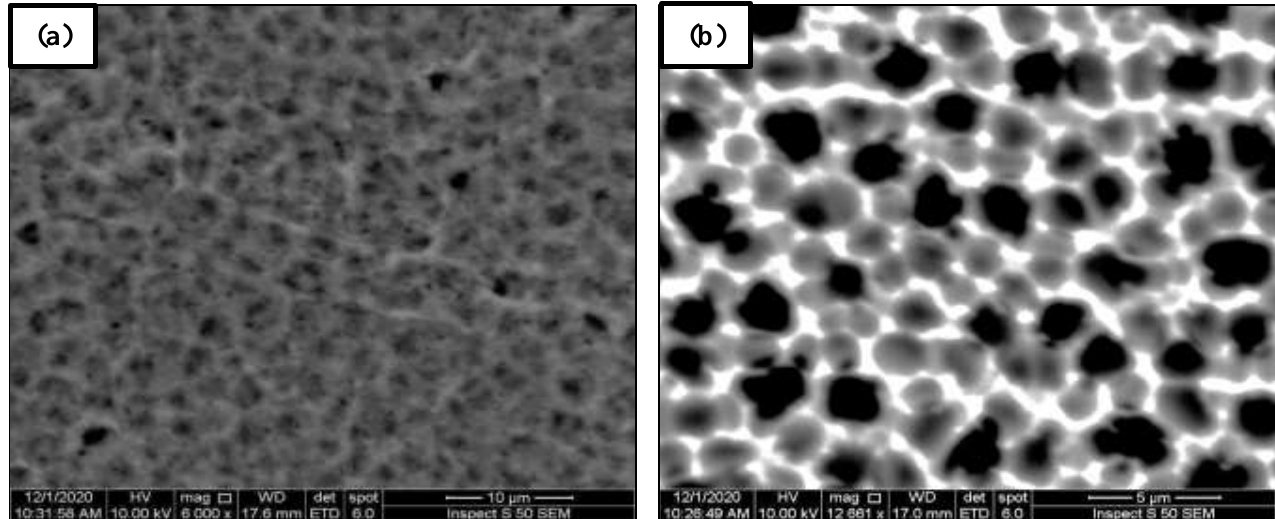
Figure 5: SEM image of PSi samples at different etching current densities (a) 12 and (b) 30 mA/cm 2 , etching time 10 min, and HFc